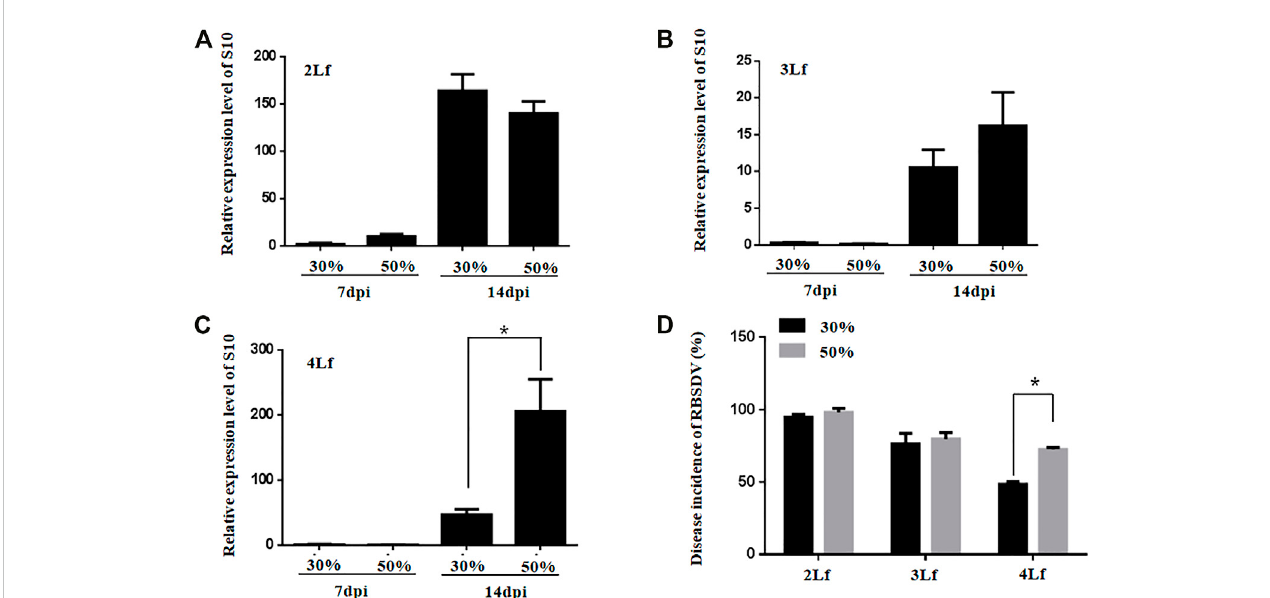
FIGURE 5 Relative expression of RBSDV S10 and the DIs of rice plants inoculated with SBPHs with different viruliferous rates at different leaf stages (Lf). (A – C) , Accumulation of RBSDV S10 in rice plants (2-, 3- or 4-leaf stage) inoculated with RBSDV viruliferous SBPHs with 30% or 50% viruliferous rates. (D) , DIs of the rice plants (2-, 3- or 4-leaf stage) inoculated with RBSDV viruliferous SBPHs with 30% or 50% viruliferous